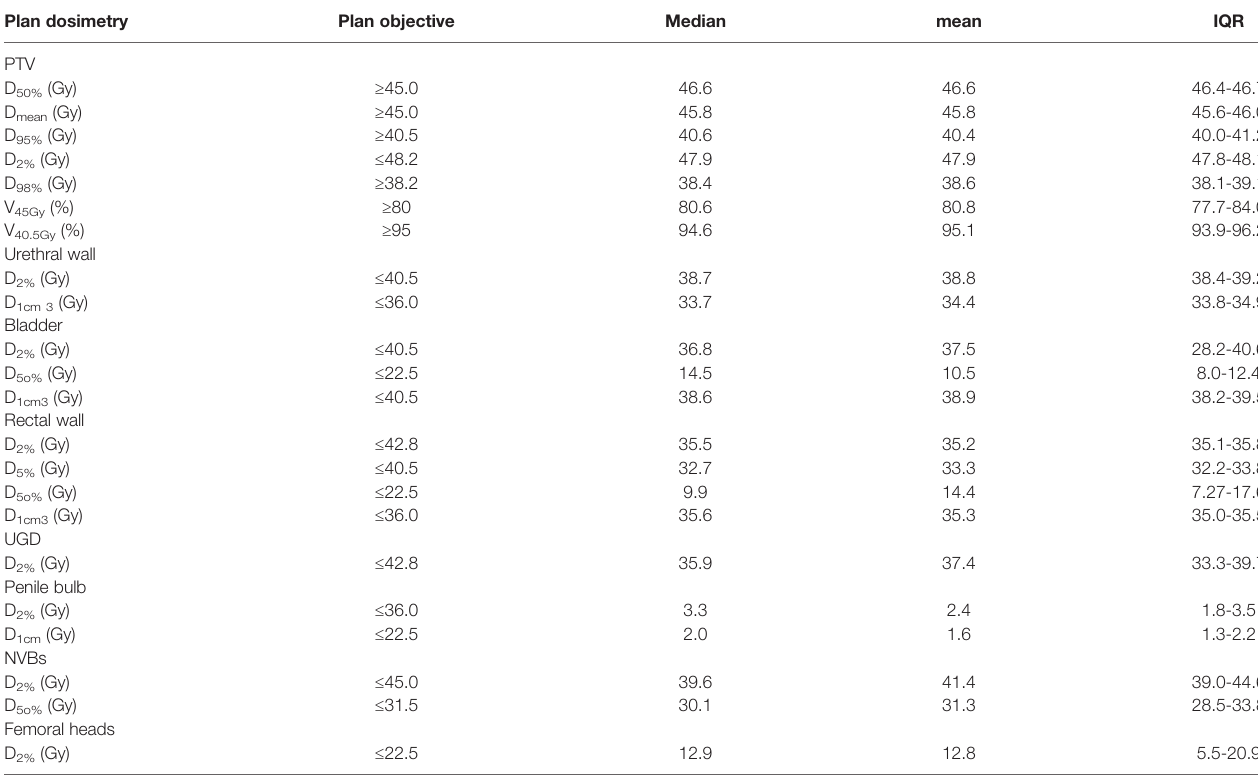
TABLE 2 | Plan objectives and dosimetric